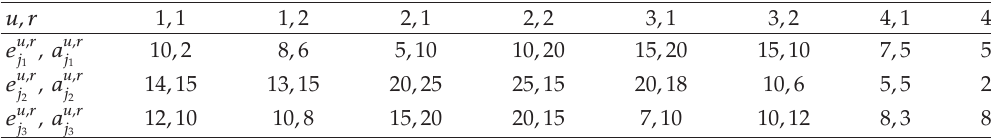
(cid:6) unit: train (cid:7) and a u,r j j